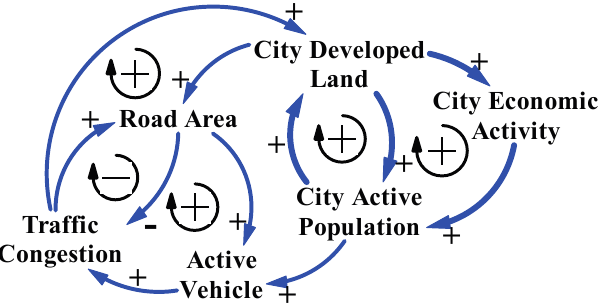
Figure 5. The CLD model reasons three key variables: City Active Population, City Developed Land, and City Economic Activity. All variables directly influence the dynamic relationships between city development and traffic congestion in Taiwan’s